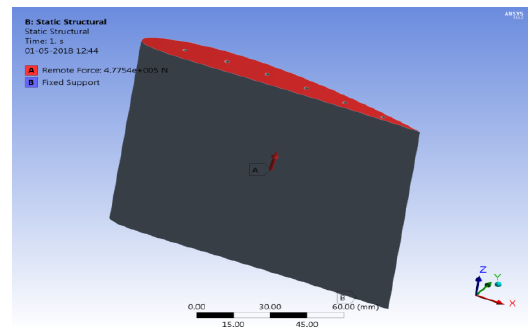
Figure 4 : Structural Boundary condition for turbine